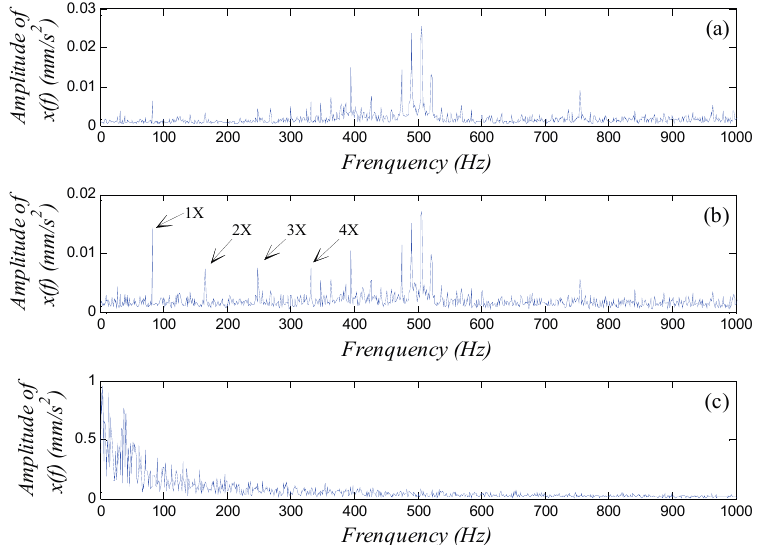
Figure 12. The output low-frequency spectra of a generalized parameter-adjusted Duffing system with the vibration signal of rolling-bearing experimental table input. The corresponding parameters in the detection system are set to ε = 100, R = 5000, a = b = 1, and ( a ) k = 9.5; ( b ) k = 10; ( c ) k =